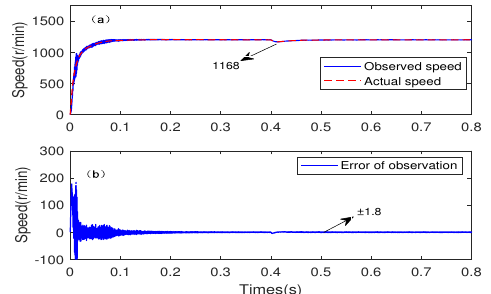
Figure 24. The speed response of VPDPI regulator under 1200 r/min. ( a ) Observed speed and actual speed. ( b ) Estimation error curve.